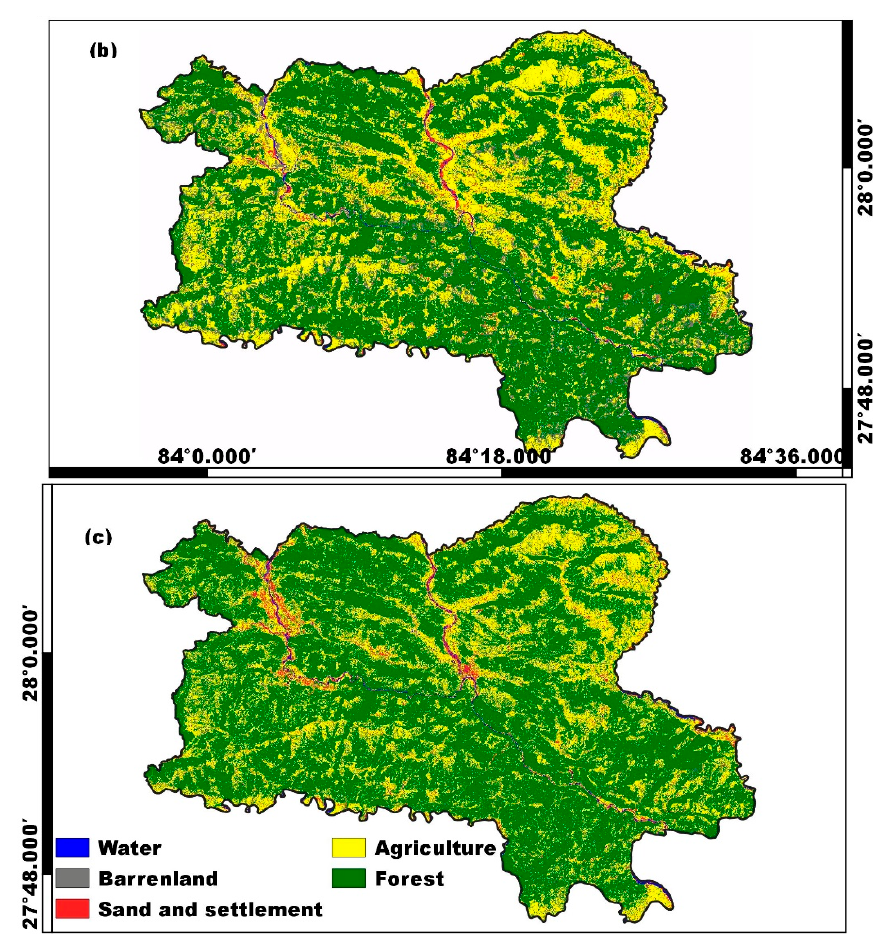
Figure 4. Land use and land cover map for ( a ) 1976, ( b ) 1991, and ( c ) 2015.